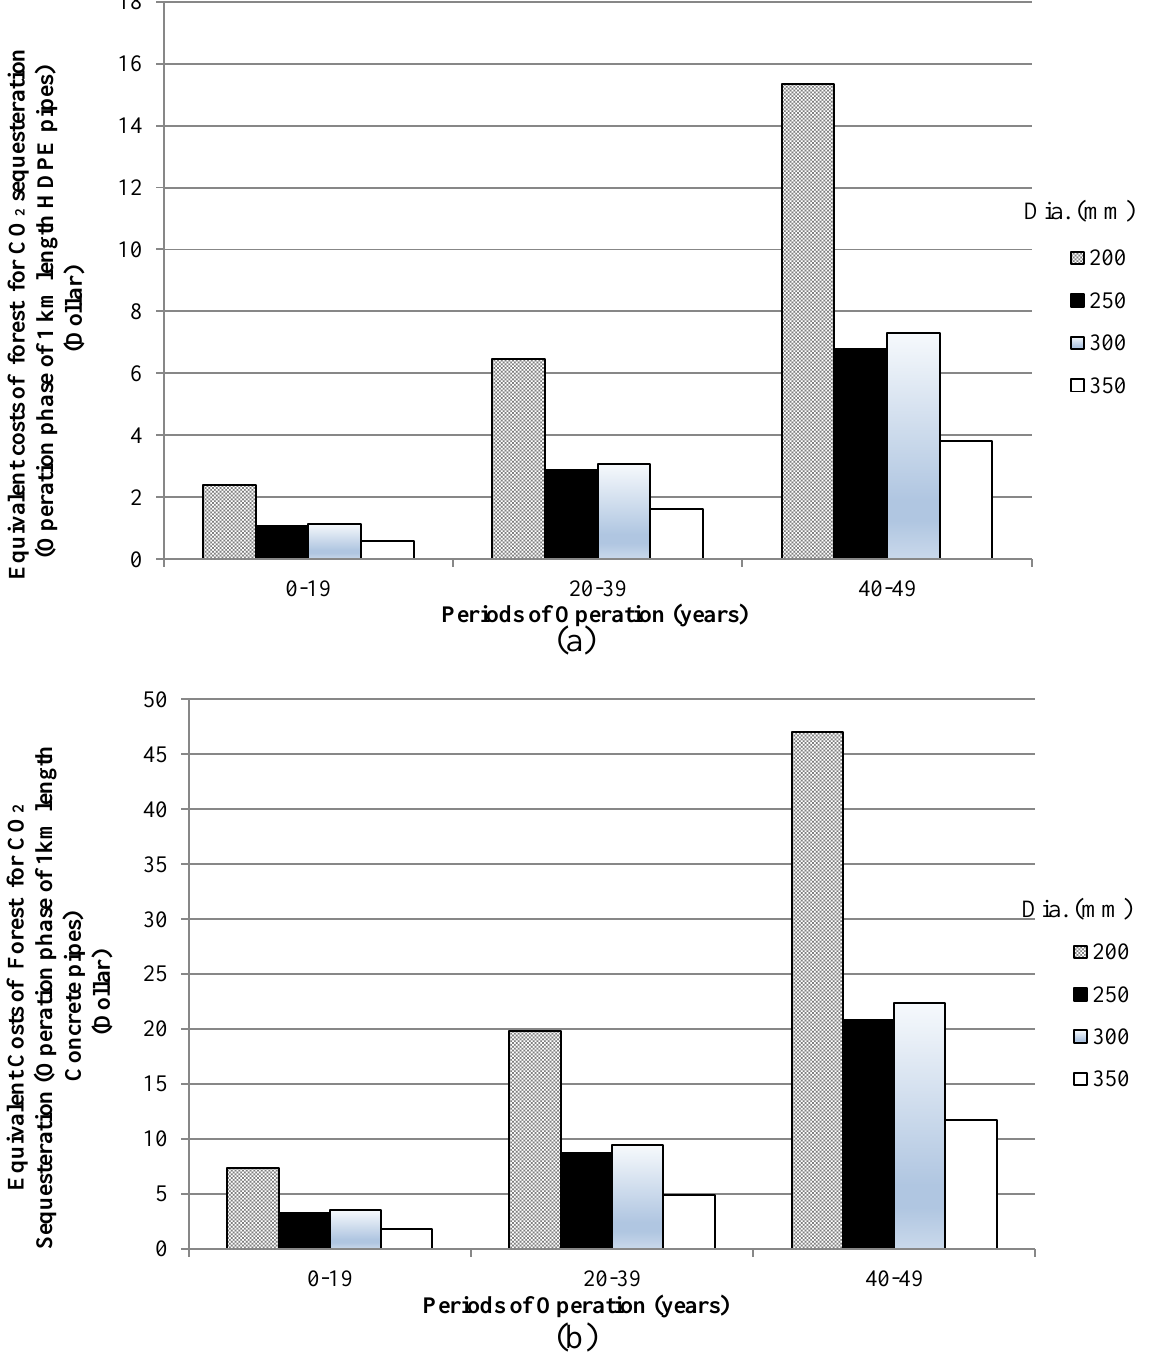
Fig. 6. The equivalent costs of forest for sequestering CO 2 emissions related to the operation phase for assumed; a) HDPE; b) Concrete